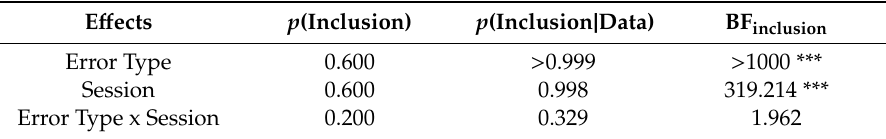
Table A4. Analysis of session e ff ects on conditional error probabilities. E ff